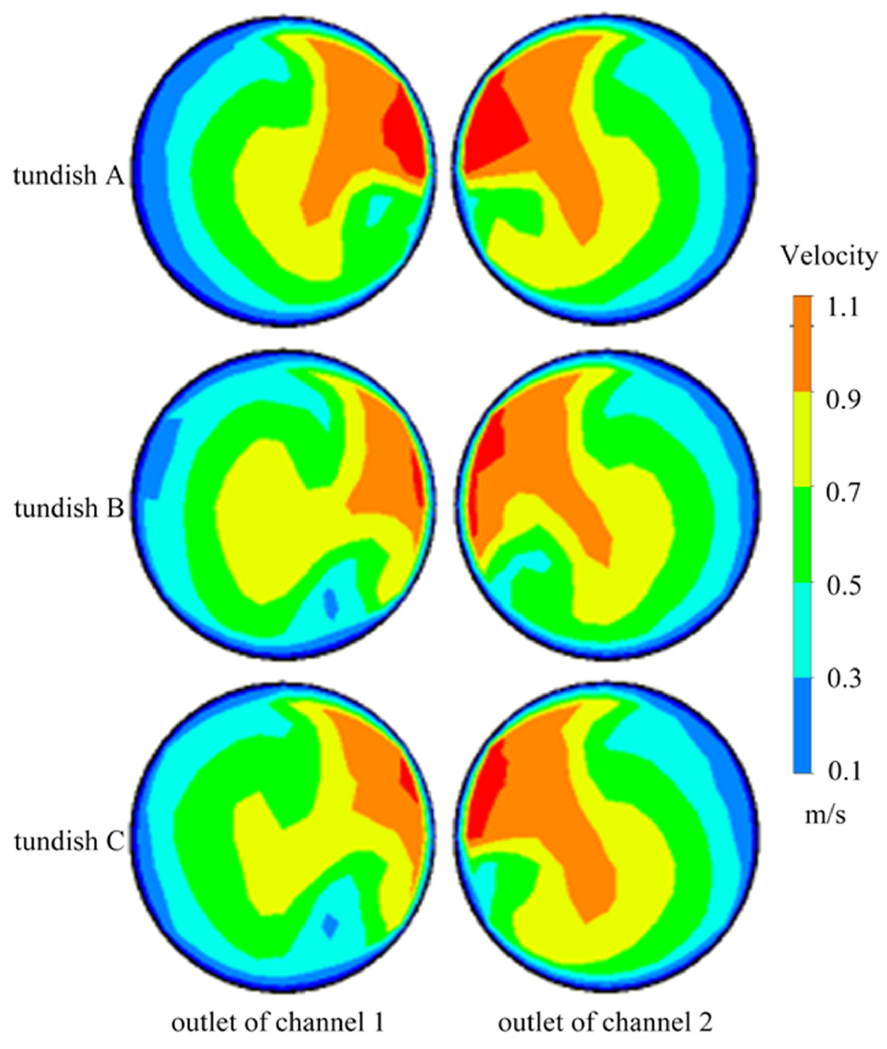
Figure 9. Flow field at the outlet of the